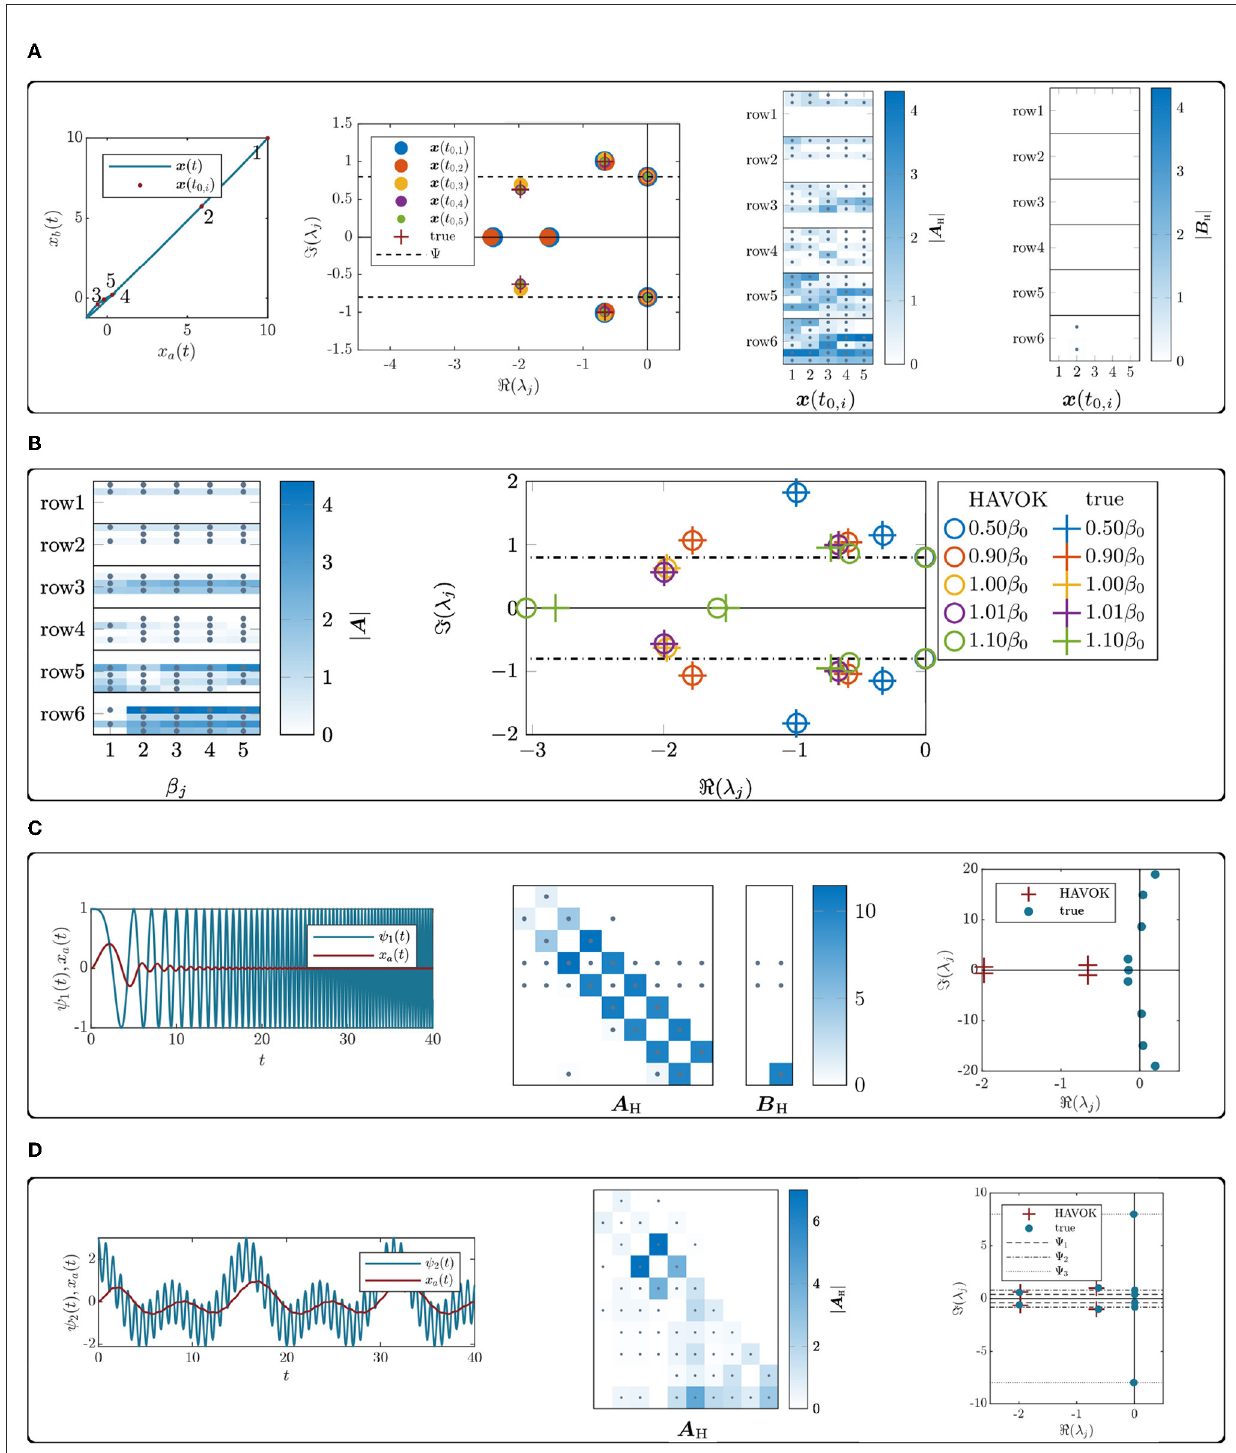
FIGURE7 (A) Dependence of the HAVOK model on changes in the physical parameters of the analytical model. For each study, the double mass oscillator is used, varying one of the system parameters only. The HAVOK-DMO for different initial conditions along one trajectory result in different input time series. The resulting HAVOK model state and input matrices are show following the convention introduced in Figure 5. The respective model eigenvalues are compared to the forcing frequency and the eigenvalues of the underlying DMO system. (B) The HAVOK-DMO model for different damping values is illustrated by the state matrix. The all-zero input matrix is not represented. The eigenvalues for each model are shown in different colors, where circles represent the HAVOK model eigenvalues and crosses the true eigenvalues. One pair of HAVOK model eigenvalues lies on the imaginary axis for every model variation. (C) The application of HAVOK to a DMO forcing with a frequency-sweep type forcing shows entries on the sub-diagonal of the state matrix. In the representation of the eigenvalues, no forcing frequency is shown as it is varied continuously. (D) HAVOK-DMO model for a system that is forced with three superimposed sinusoids, where the HAVOK model catches both the system eigenvalues and the forcing